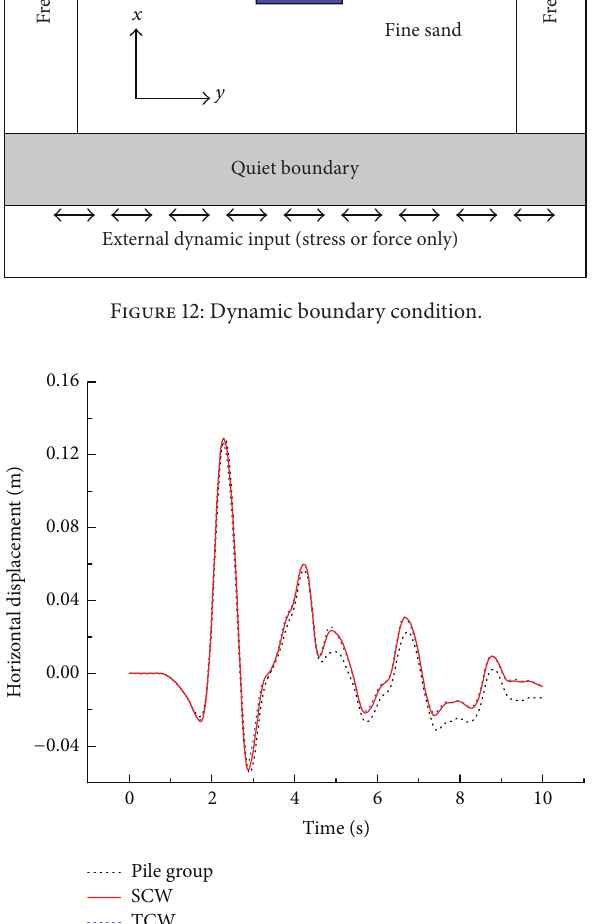
Figure 13: Horizontal displacement time histories of cap for three